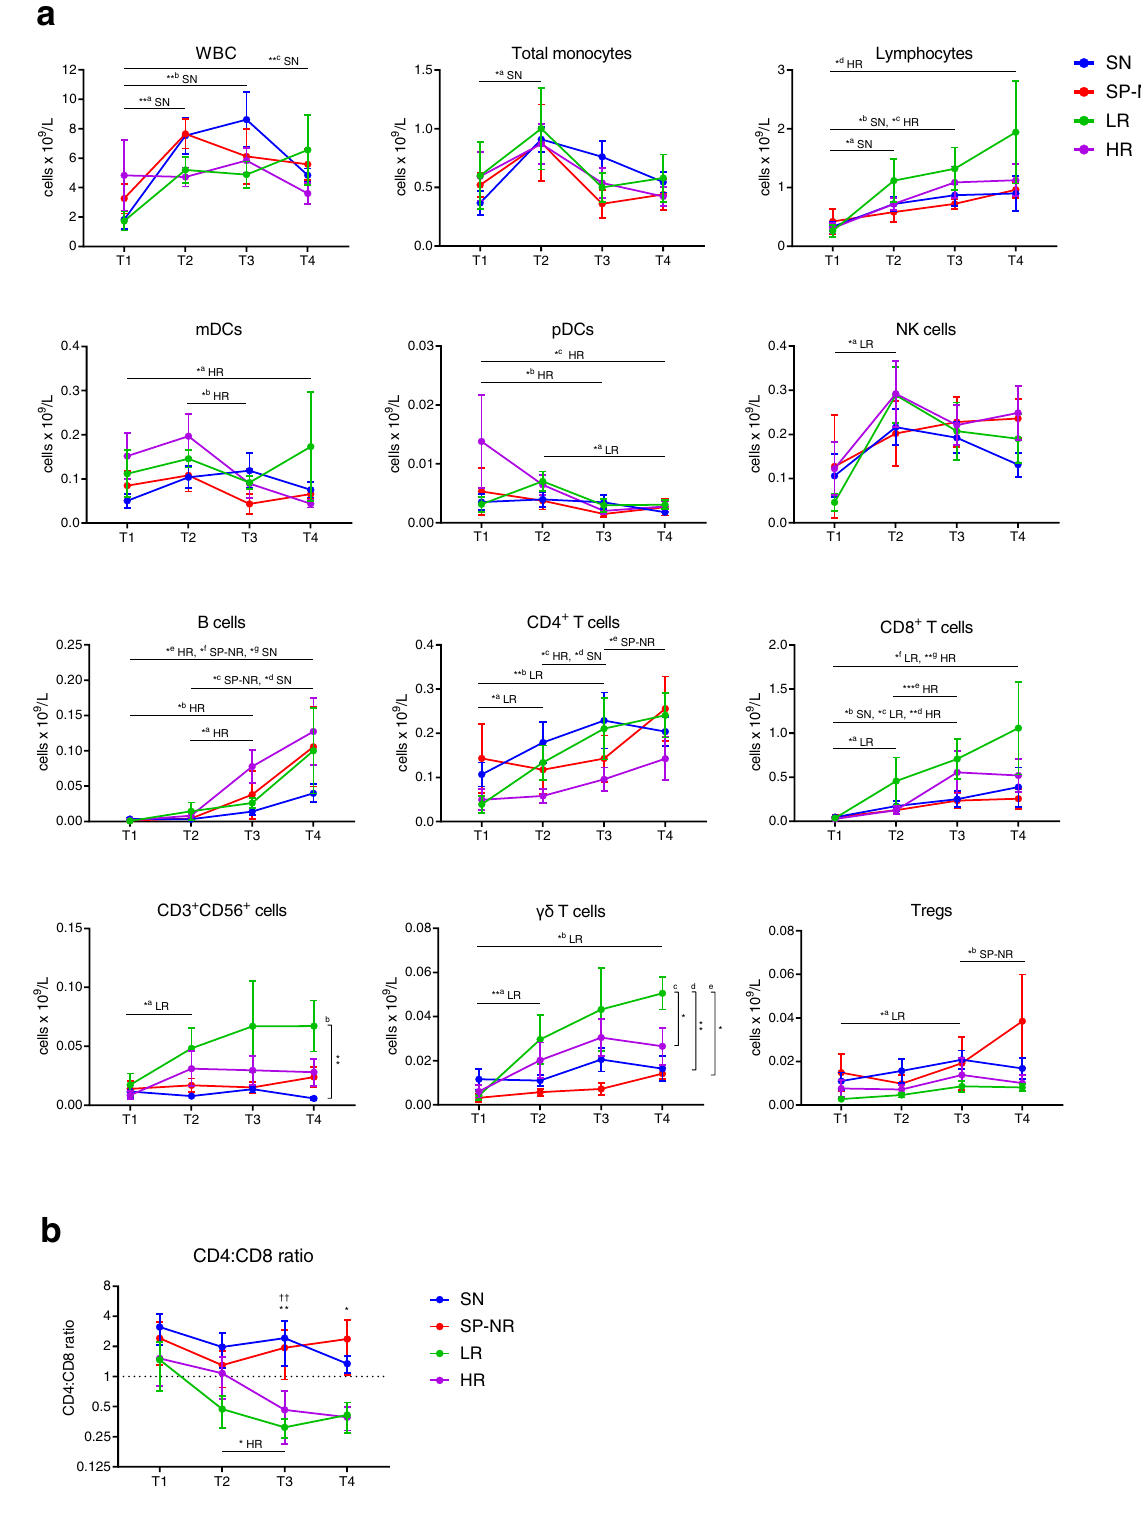
the total MAIT cell population (CD3 + V α 7.2 + CD161 high ) was The median percentage of CD8 + MAIT cells at T2 was 40.3-fold higher in LR than HR patients (medians 0.235% and 0.006% of live examined without prior gating on CD8 (Supplementary Fig. 6A, B), cells, respectively). CD8 + MAIT cell absolute counts and and when MAIT frequencies were measured as a percentage of total percentages were also signi fi cantly higher at T4 in LR compared CD3 + cells (Supplementary Fig. 6C, D). to both HR and SN (Fig. 5a, b). To further add further context to CD8 + MAIT cell frequencies at T2 and T4 in patients with the relevance of MAIT cells, similar fi ndings were observed when HCMV reactivation inversely correlated with the HCMV DNA NATURE COMMUNICATIONS| (2022) 13:2603